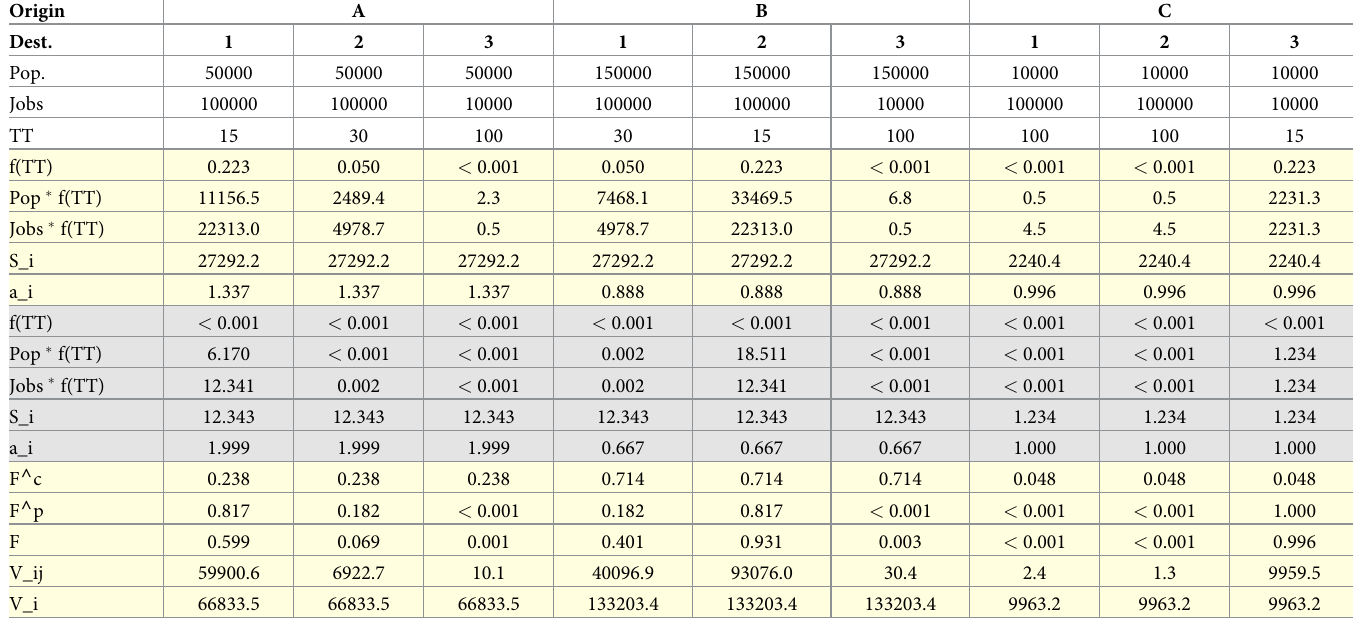
Table 1. Summary description of the synthetic example: Hansen-type accessibility S i , Shen-type accessibility a i , and spatial availability V i with beta = 0.1 (light yel- low) and beta = 0.6 (light grey).